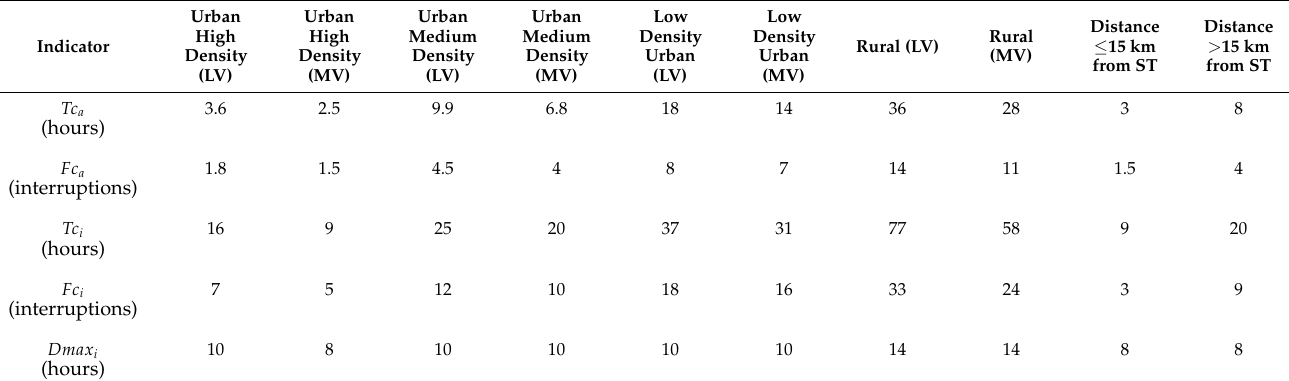
Table 12. Continuity limits by grouping in